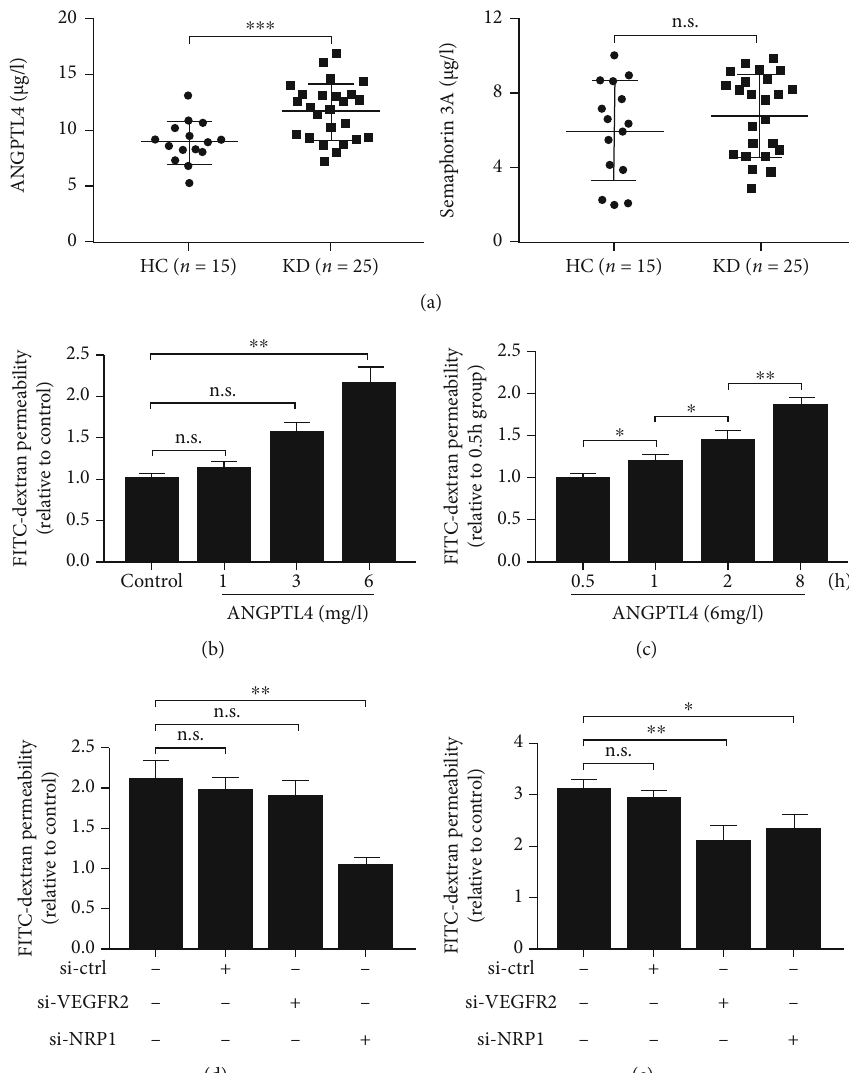
Figure 4: ANGPTL4 contributes to the permeability of HCAEC monolayers by binding NRP1. (a) Levels of ANGPTL4 and semaphorin3A in the HC group and the KD group. (b, c) EC permeability assay upon treatment of HCAECs with di ff erent doses of rANGPTL4 or with 6mg/l rANGPTL4 in di ff erent times. EC permeability assay upon transfection of control siRNA, VEGFR2 siRNA, or NRP1 siRNA and stimulation with (d) 6mg/l rANGPTL4 for 8 h or (e) 60 μ g/l VEGF for 6 h. PBS treatment as control. Data are expressed as M ± SD from 3 separate experiments (b – e). ∗ P < 0 : 05 ; ∗∗ P < 0 : 01 ; ∗∗∗ P < 0 : 001 ; n.s.: not signi fi